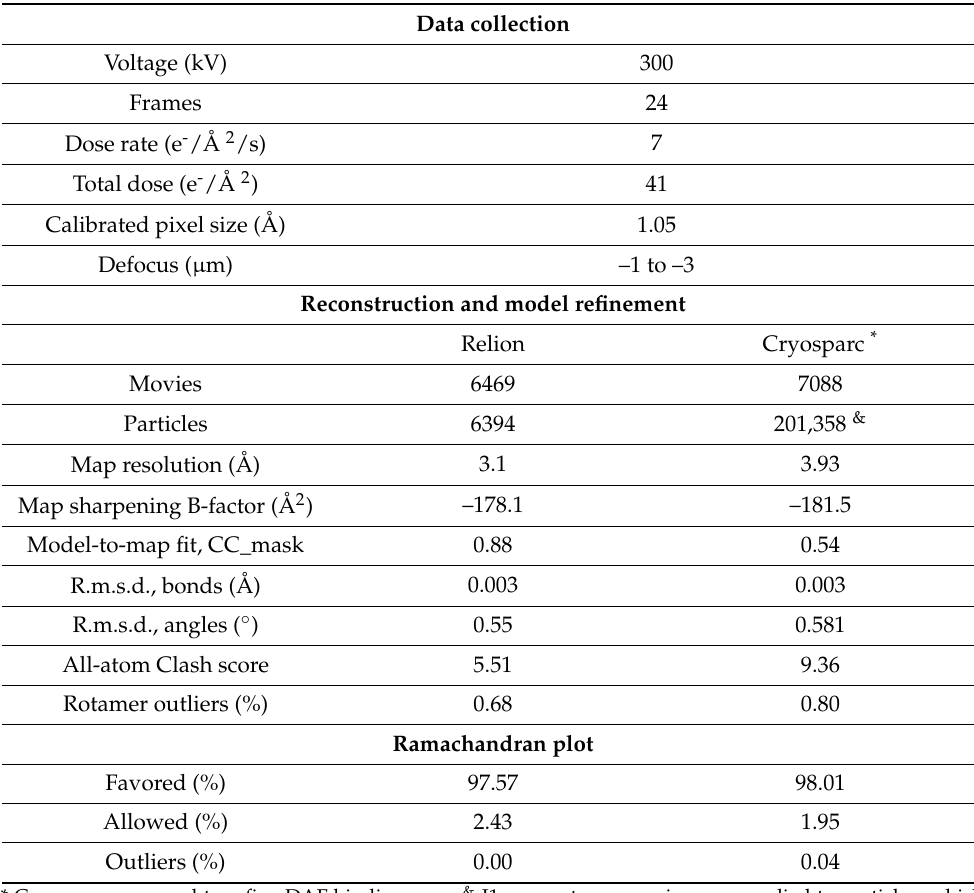
Table 1. Data collection, reconstruction and model